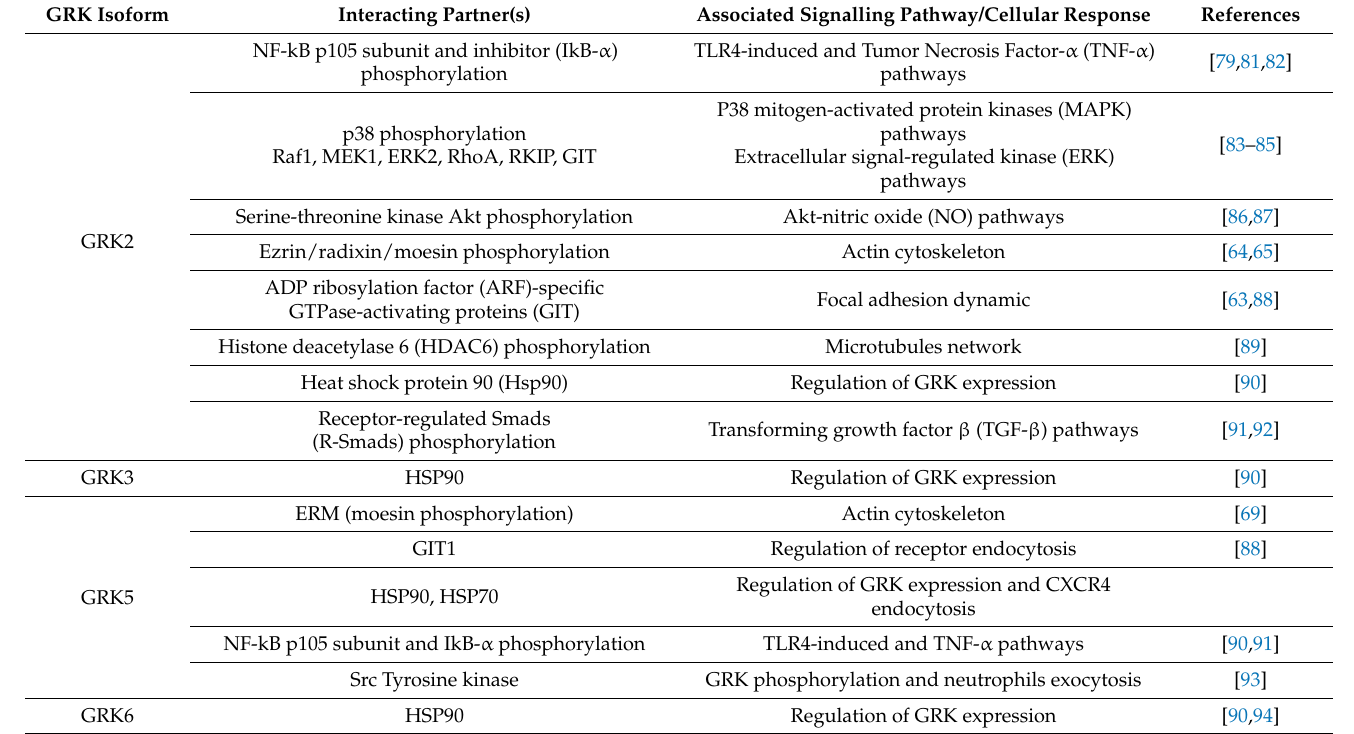
Table 1. GRK isoforms and their established functions in immune cells and inflammation. GRK